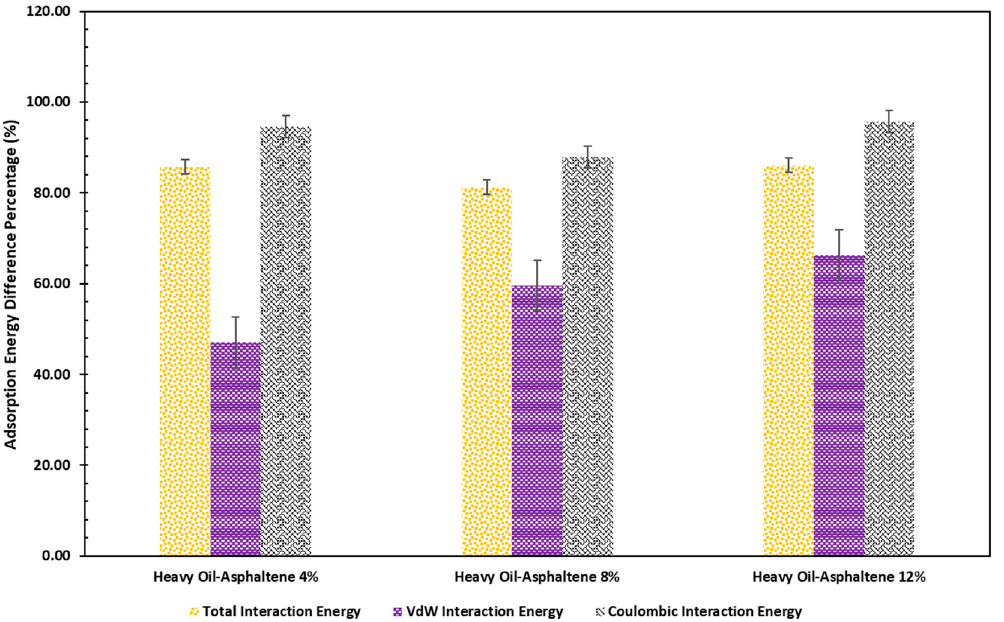
Figure 2. Comparison between the percentage of adsorption energy difference relative to the ambient temperature for each system due to the temperature change from 298 K to 498 K.